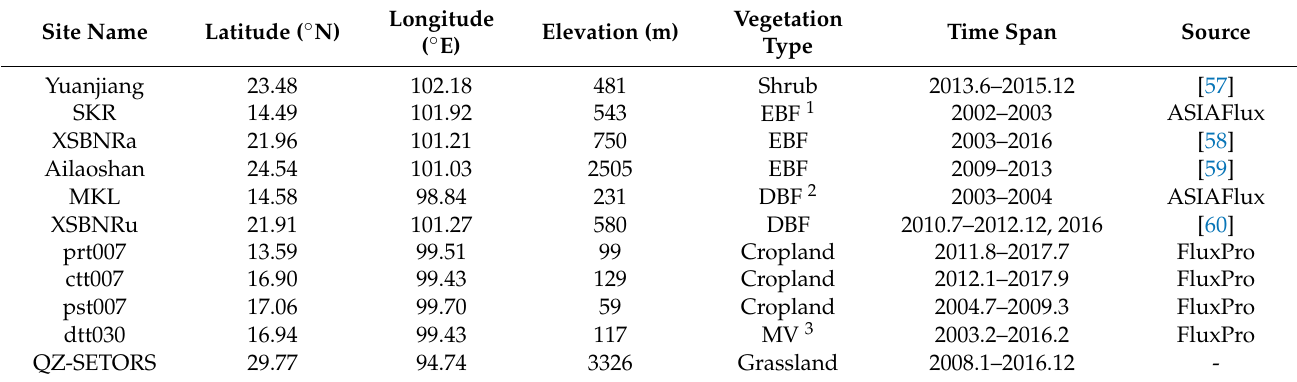
Table 3. Characteristics of the flux sites used in this